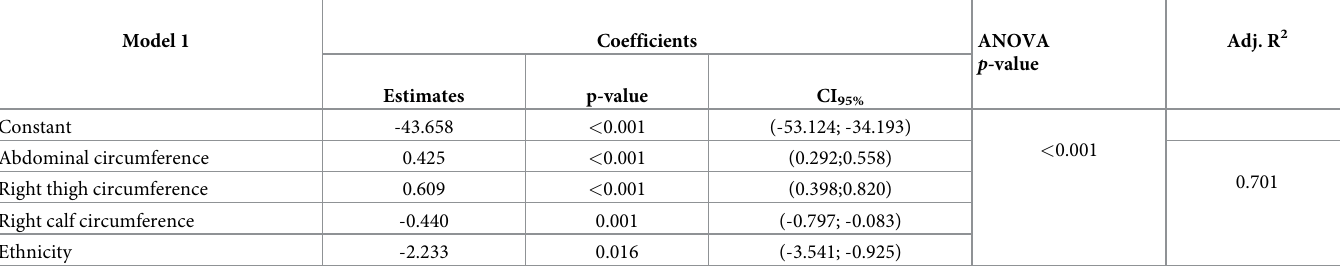
Table 3. Multiple linear regression model for BF% in elite male rink hockey